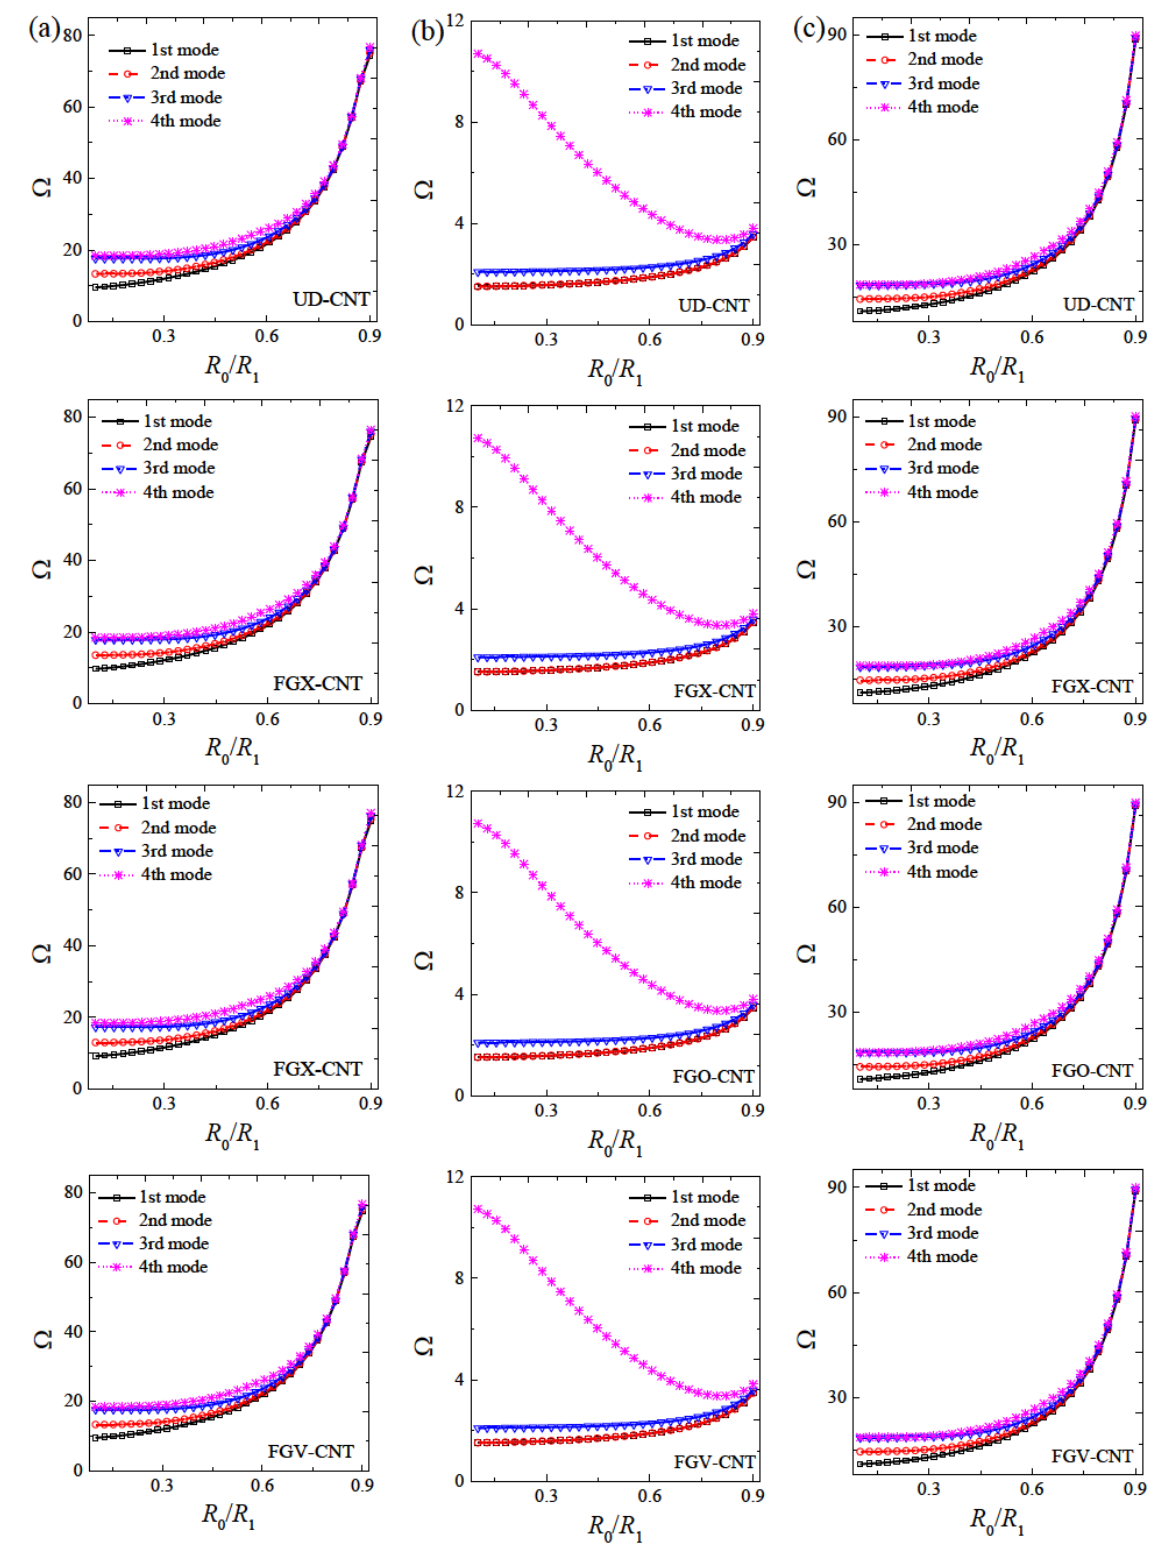
Figure 8: Variation of the first four frequency parameters Ω versus the inner-outer radial ratios for FG-CNT reinforced composite annular sector plates:(a) E 3 E 3 E 3 E 3 ; (b) E 1 E 1 E 1 E 1 ; (c)